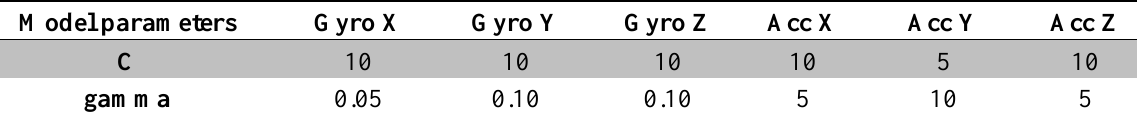
Table 6. Optimal values of parameters identified for training Nu-SVR.